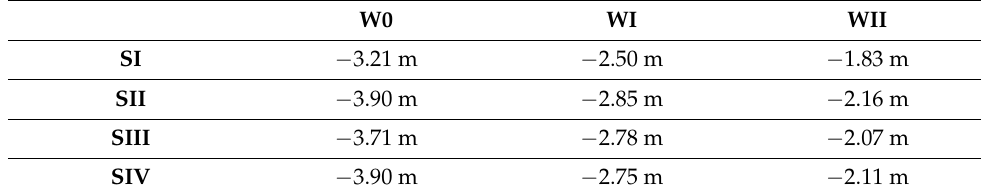
Figure 13. ( a ) . Difference in the bottom elevation between Scenarios SII, SII WI, and SII WI for the whole cross-section. ( b ). Difference in the bottom elevation between Scenarios SII, SII WI, and SII WI for the lower part of the cross-section. Table 4. The maximum erosion below the Gniew Barrage for scenarios